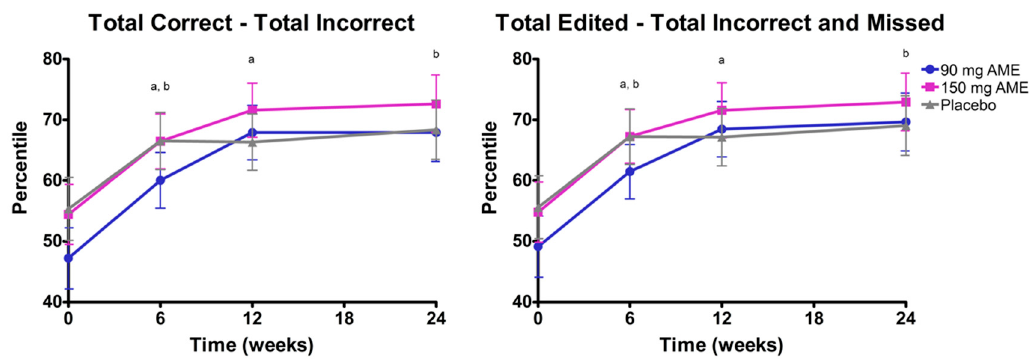
Figure 2. The effect of Aronia melanocarpa extract (AME) supplementation on attention, assessed by the number cross-out test. Data are presented as actual mean ± SEM. Analysis was performed with a linear mixed model using estimated means, with correction for baseline values. Post hoc analyses were performed for the factor time. Statistically significant differences between two timepoints are denoted by the letter a or b. Higher percentile scores indicate better performance, corrected for age. Table 2. The e ff ect of Aronia melanocarpa extract supplementation on mood scores afraid, angry, confused, energetic, happy, sad, tense, and tired. 1